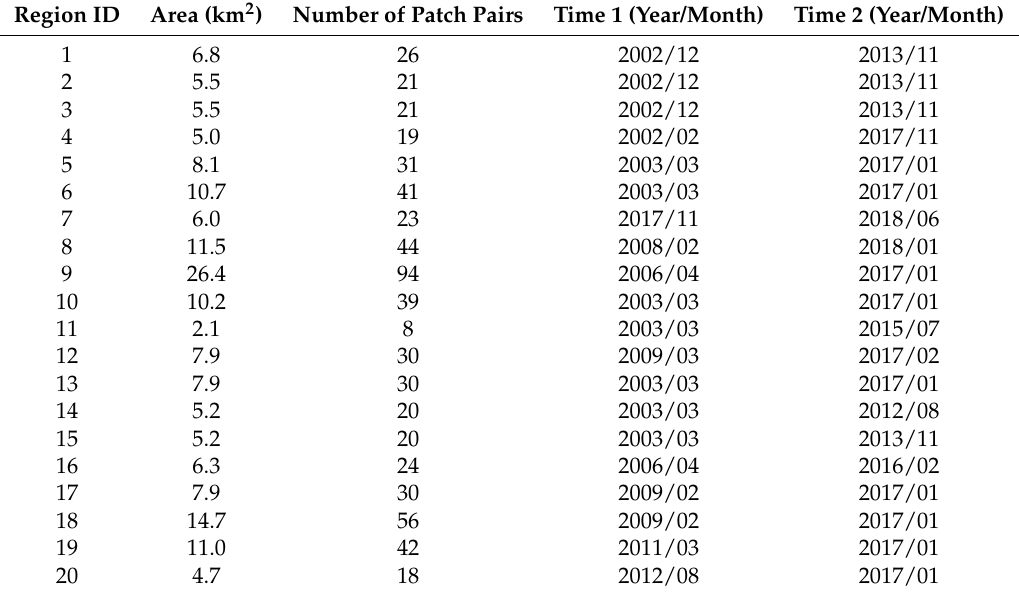
Figure 3. Left: geospatial distribution of our new dataset. Right: an enlarged image patch. Table 1. Details of each region in our collected